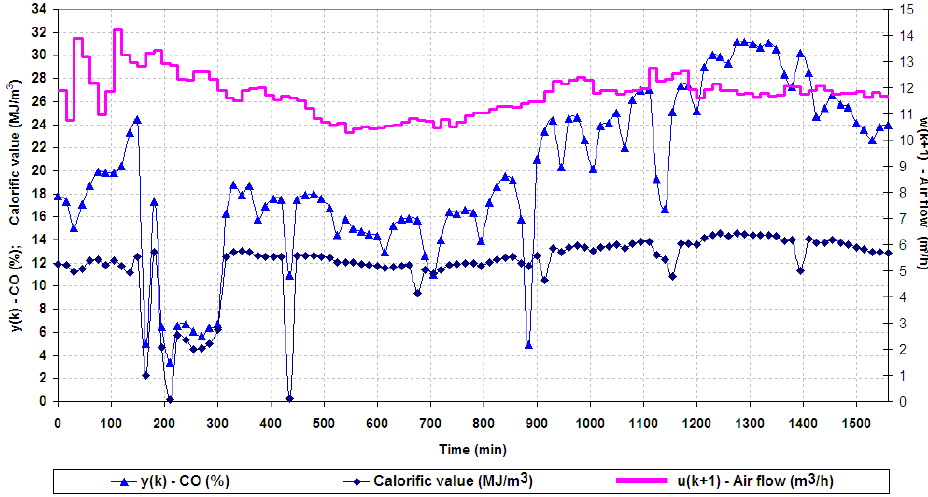
Figure 8. Maximization of CO through optimization of airflow by ESC